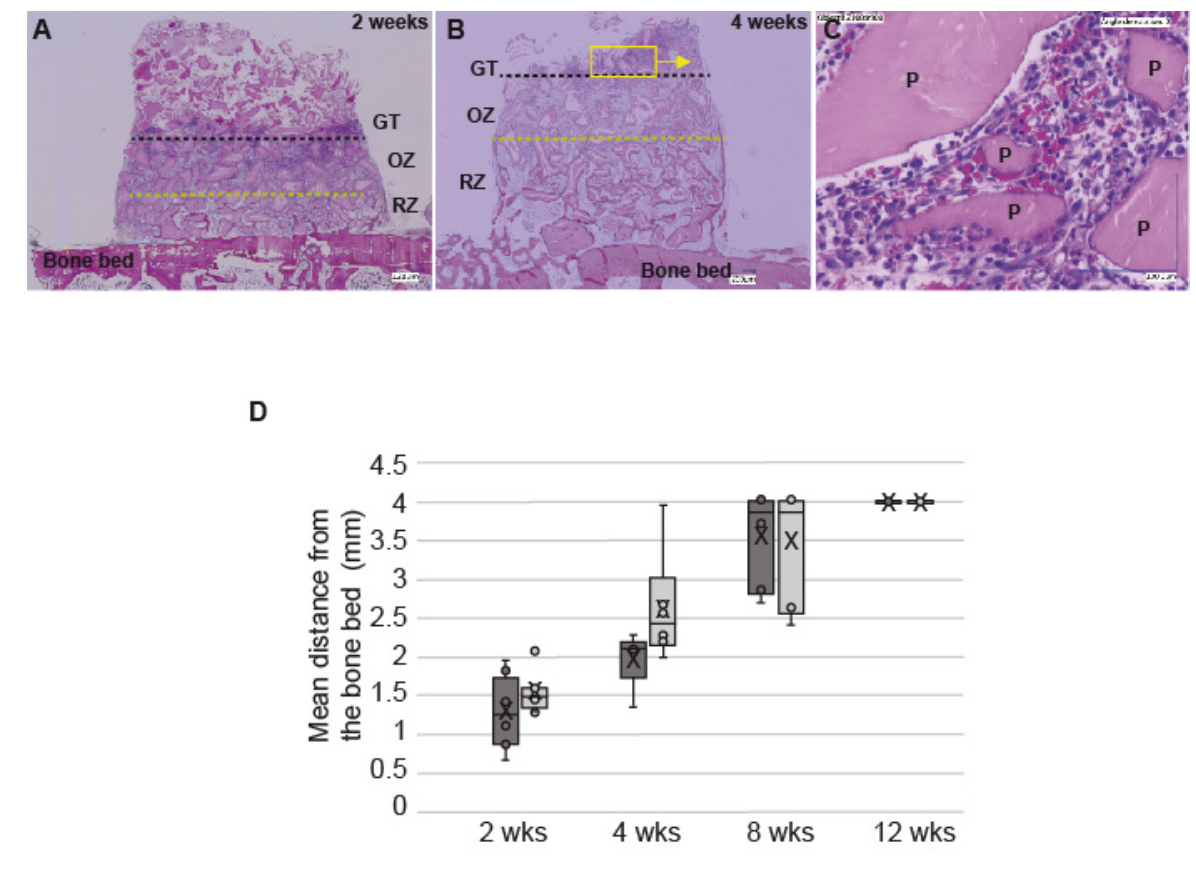
Figure 3. Migration of the granulation tissue. ( A , B ) representative histological slides showing the migration of the granulation tissue within cylinders filled with DBBM-C soaked in NaCl 0.9% at 2 weeks and 4 weeks (dotted black line, mean height of the granulation tissue (GT); dotted green line, inferior limit of the osteogenic zone (OZ) upper limit of the remodeling zone (RZ). Yellow box and arrow: magnification on the picture indicated by the arrow. ( C ) Higher magnification of the granulation tissue showing mononuclear cells surrounding the particles of DBBM-C. ( D ) Box plot showing the mean distance (mm) between the bone bed and the GT in the cylinders filled with DBBM-C scaffolds either pre-treated with blood (dark grey) or NaCl 0.9% (light grey) at 2, 4, 8 and 12 wks. Horizontal line: median; Boxes: 25–75%; ×: mean; Bars: range of non-outliers.